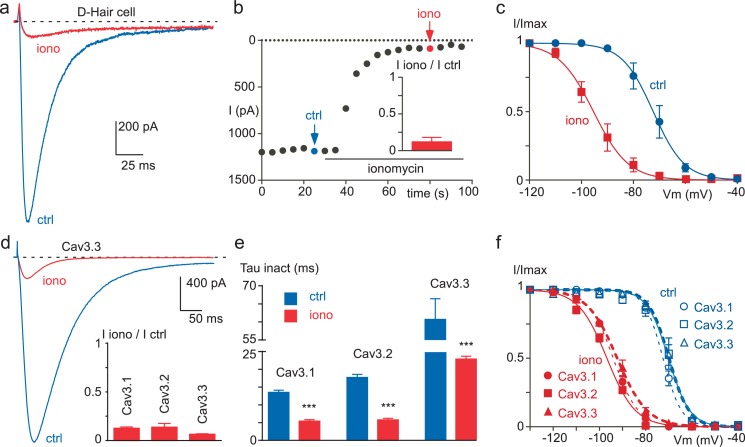
Ionomycin induces inhibition of neuronal T-type and recombinant Cav3 currents.(a–c) Extracellular application of ionomycin induces inhibition of the native T-type current in D-hair sensory neurons. (a) Effect of 10 µM ionomycin (iono) on the T-type current recorded from a D-hair sensory neuron. (b) Time course and average effect (inset) of ionomycin (n = 5). (c) Steady-state inactivation of the native T-type current before (ctrl) and after ionomycin application (n = 5). (d–f) Ionomycin induces inhibition of the recombinant Cav3.1, Cav3.2 and Cav3.3 currents. (d) Effect of ionomycin application (10 µM) on the Cav3.3 current amplitude. Average effect of ionomycin on Cav3.1, Cav3.2 and Cav3.3 currents (inset, n = 6–7 per bar). (e) Inactivation kinetics of the Cav3 currents in the absence and in the presence of ionomycin (n = 6–7 per bar). (f) Steady-state inactivation of Cav3.1, Cav3.2 and Cav3.3 currents before and after ionomycin application (n = 6–7). In (a), (b), (d) and (e), the currents were recorded at −30 mV from a holding potential (HP) of −80 mV. In (c) and (f), the currents were elicited at −30 mV from HPs ranged from −130 to −40 mV (5 s duration) and the data were fitted with the Boltzmann equation.